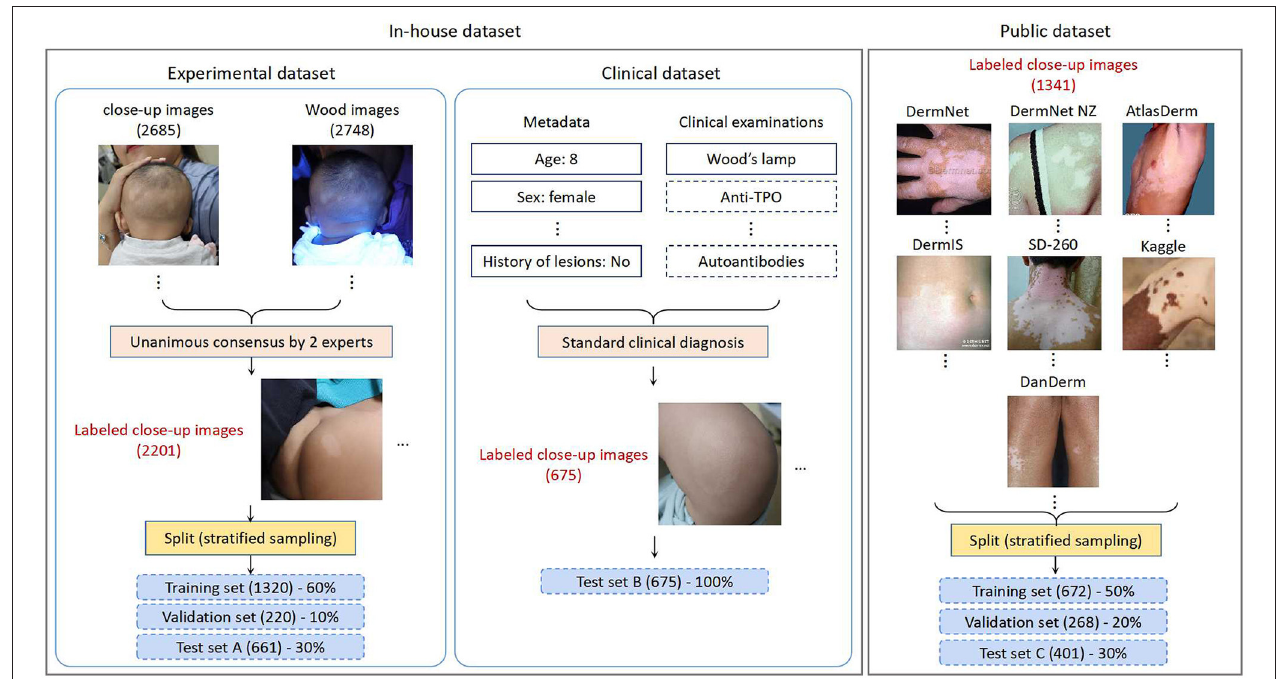
FIGURE 1 | An overview of the datasets used for this study.